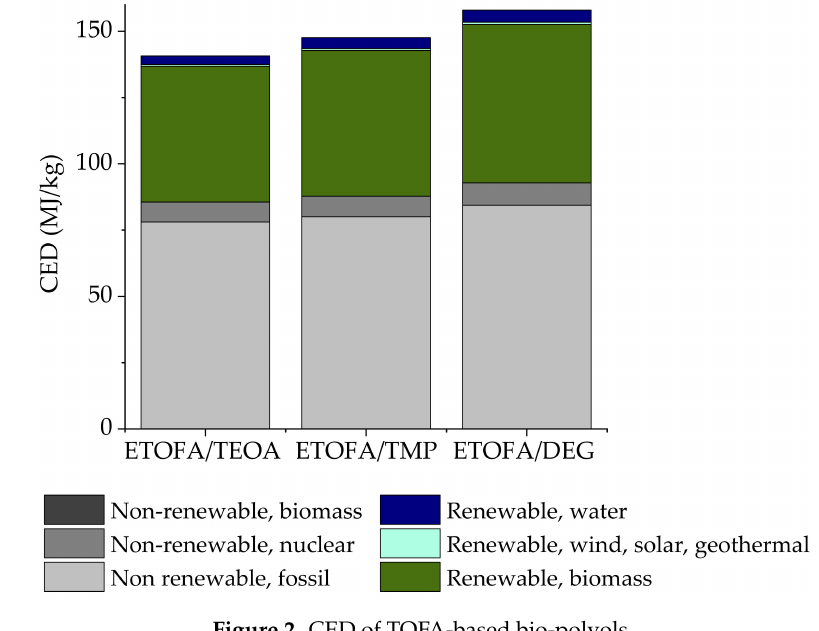
Figure 2. CED of TOFA-based